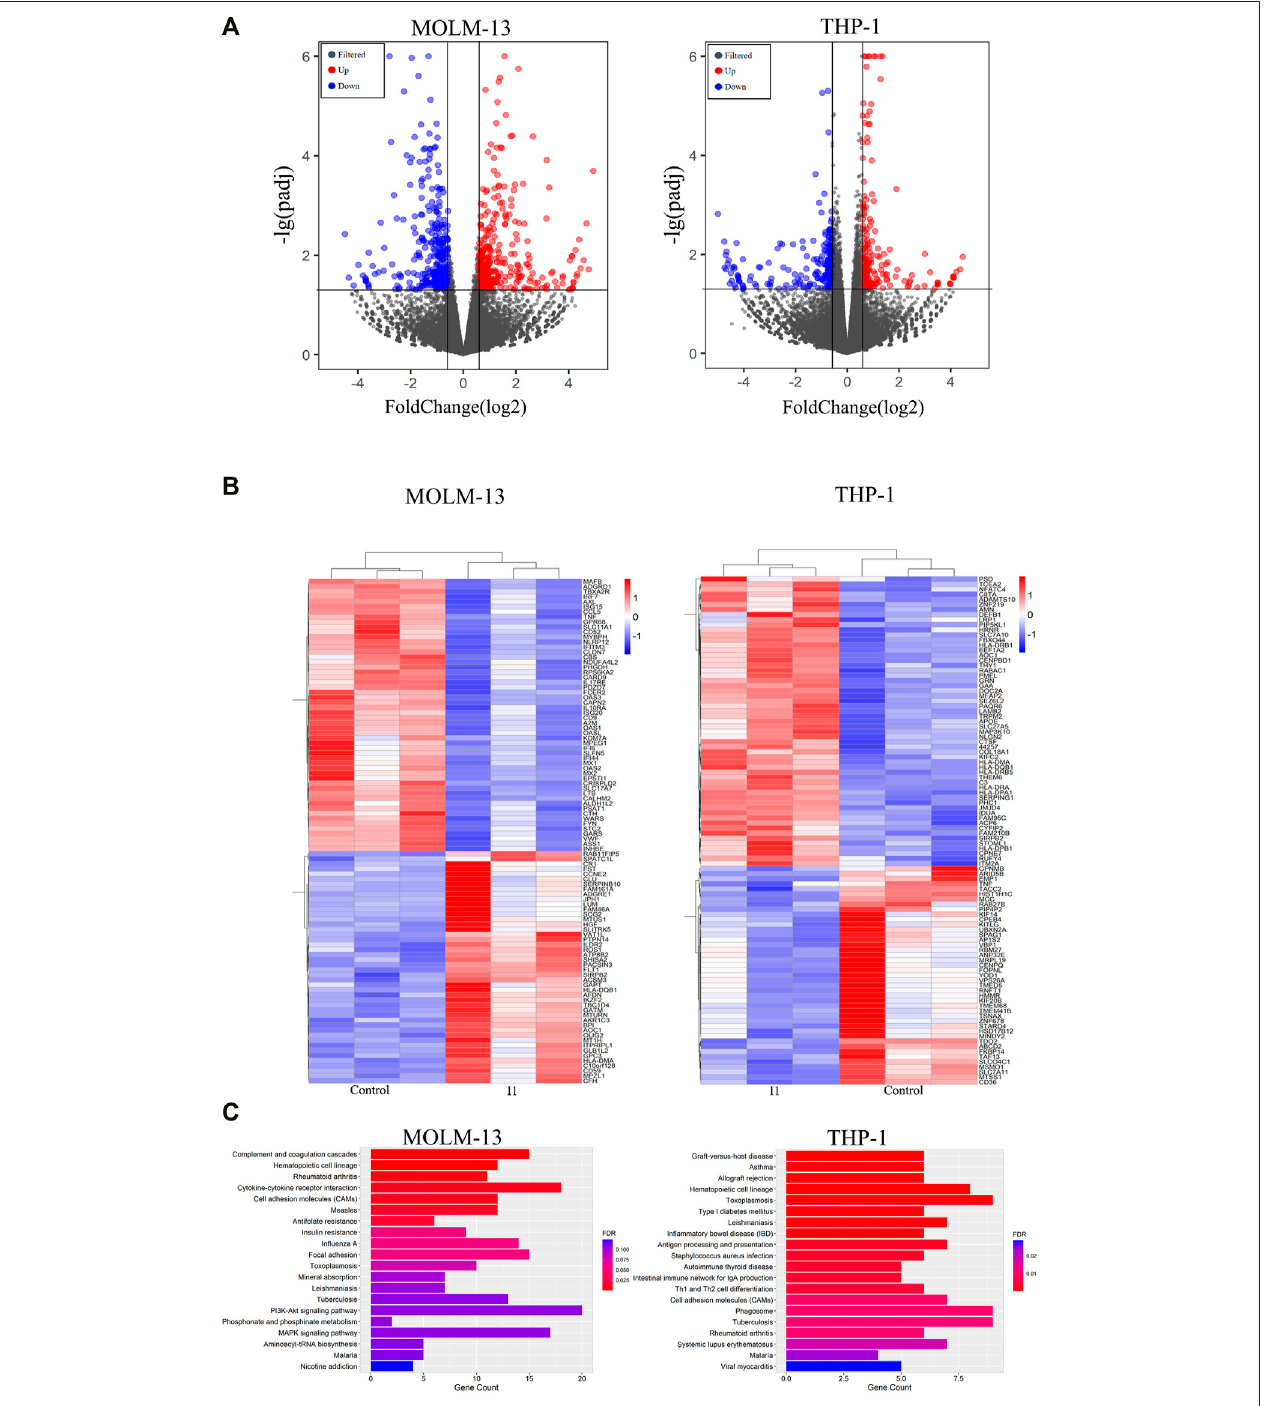
FIGURE 6 | I1 promotes cell differentiation via activating hematopoietic cell lineage pathway in MOLM-13 and THP-1 Cells. (A) Volcano plots of MOLM-13 and THP-1cells. (B) Theheatmapofdifferentiallyexpressedgenes(DEGs).ThebarsfrombluetoreddenotestheexpressionlevelsofDEGsfromlowtohigh.(100geneswith p < 0.05 and |log 2 FC| > 0.58 based on their p value in both cell lines). (C) KEGG pathway analyses on all DEGs. MOLM-13 and THP-1 cells were incubated with 1, or 0.7 μ M I1, respectively for 48 h. The fi gures are representative of three independent experiments.